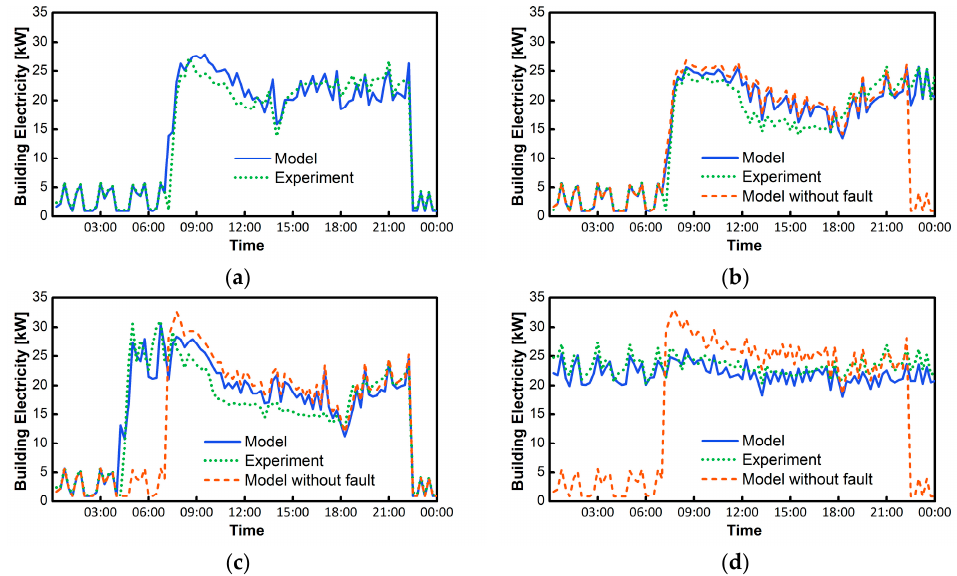
Figure 6. Total building electricity consumptions of baseline and faulted scenarios: HVAC setback error (winter). ( a ) baseline; ( b ) delayed onset; ( c ) early termination; ( d ) no setback.